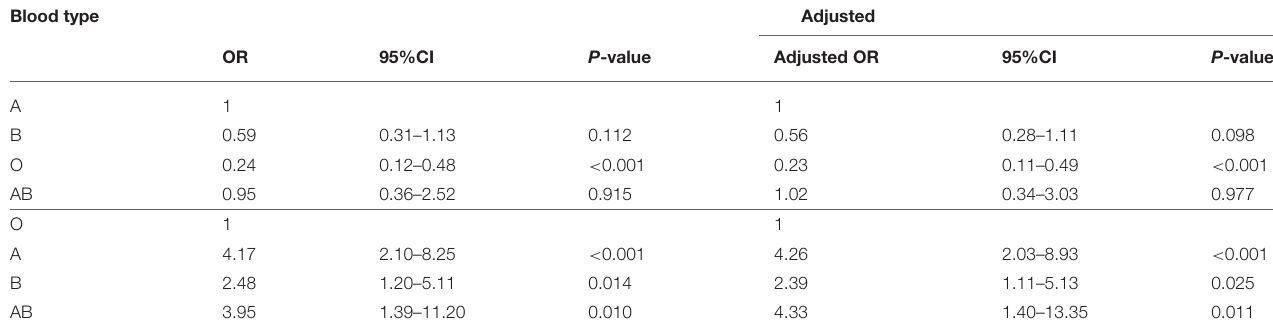
TABLE 4 | Comparison the Gensini score (GS) of different ABO blood groups in ESRD patients with CAD. Blood